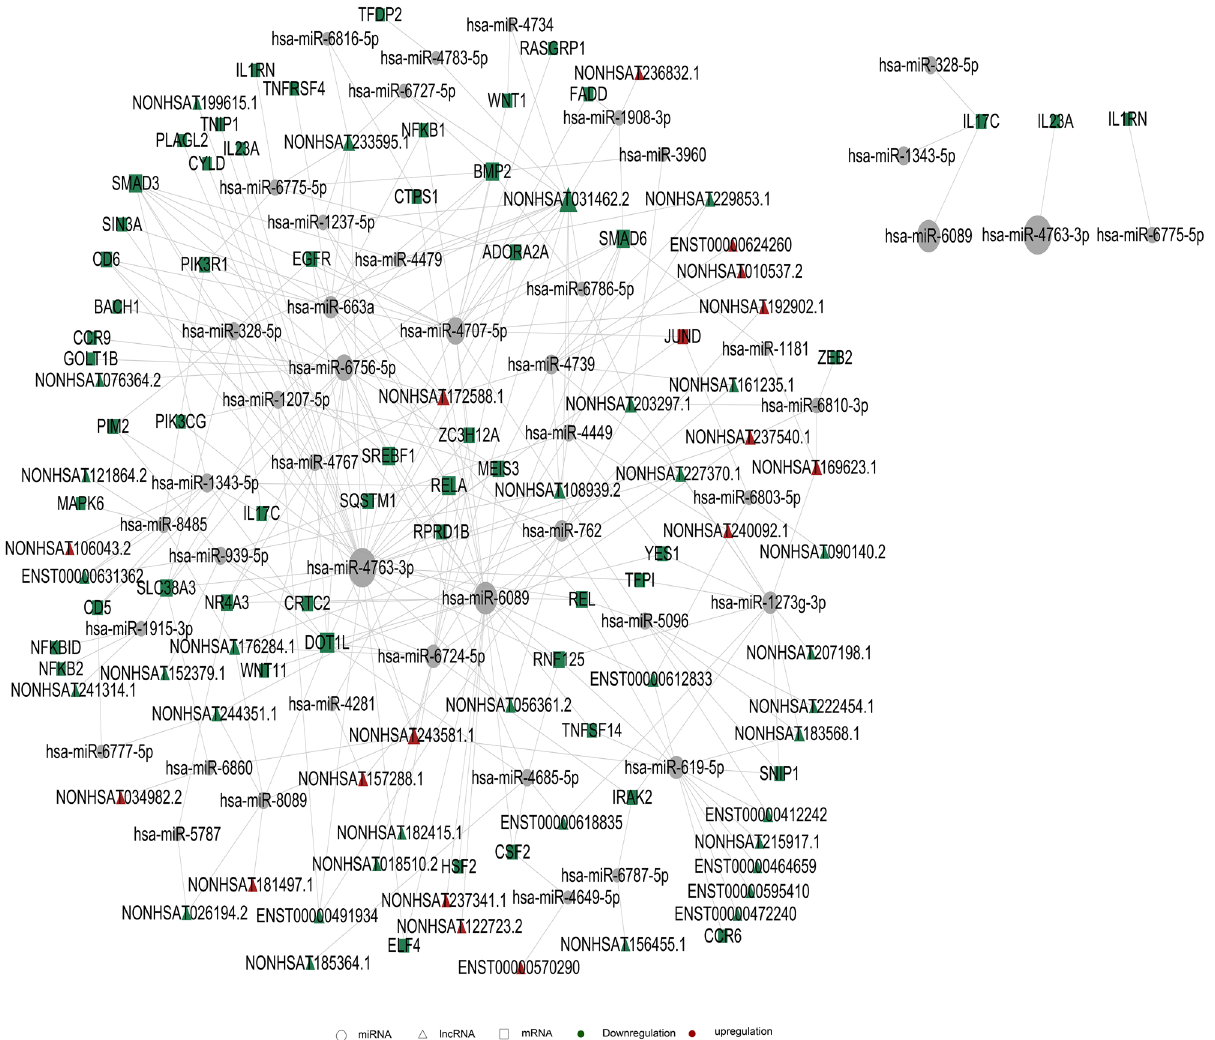
network represents a gene, the lines represent microRNA that are regulated between genes. The size of the circle represents the gene’s ability to interact with other genes. We use degree to quantify it, and the larger the